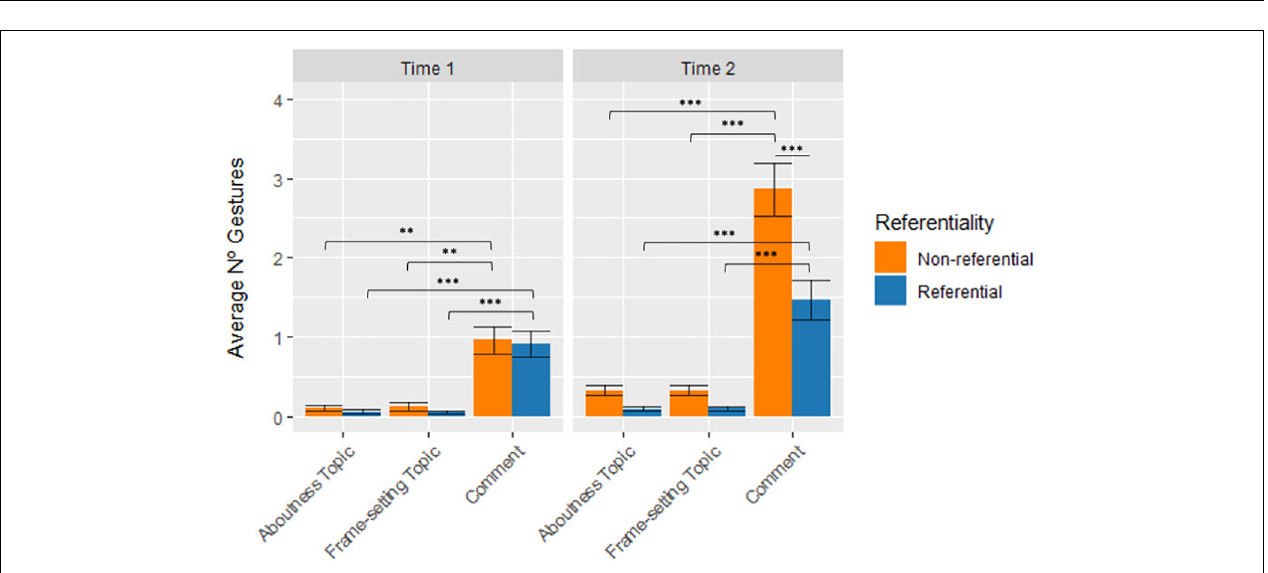
FIGURE 7 | Average number of gestures per child across Time, Gesture Referentiality, and Focus/Background. Error bars represent standard error. ∗ stands for p ≤ 0.05; ∗∗ stands for p ≤ 0.01; and ∗∗∗ stands for p ≤ 0.001.